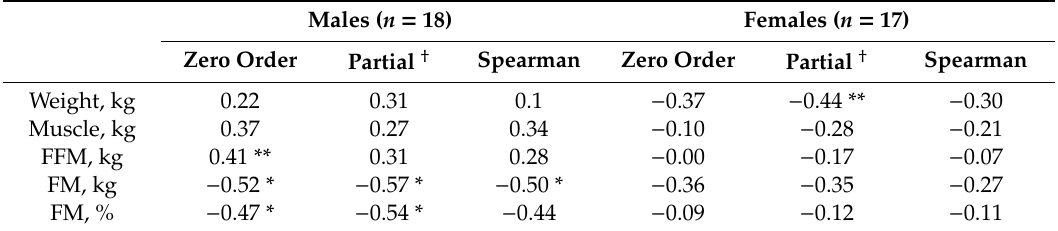
Table 4. Correlations between pre-training values and respective changes (deltas) in weight and components of body composition after five weeks of